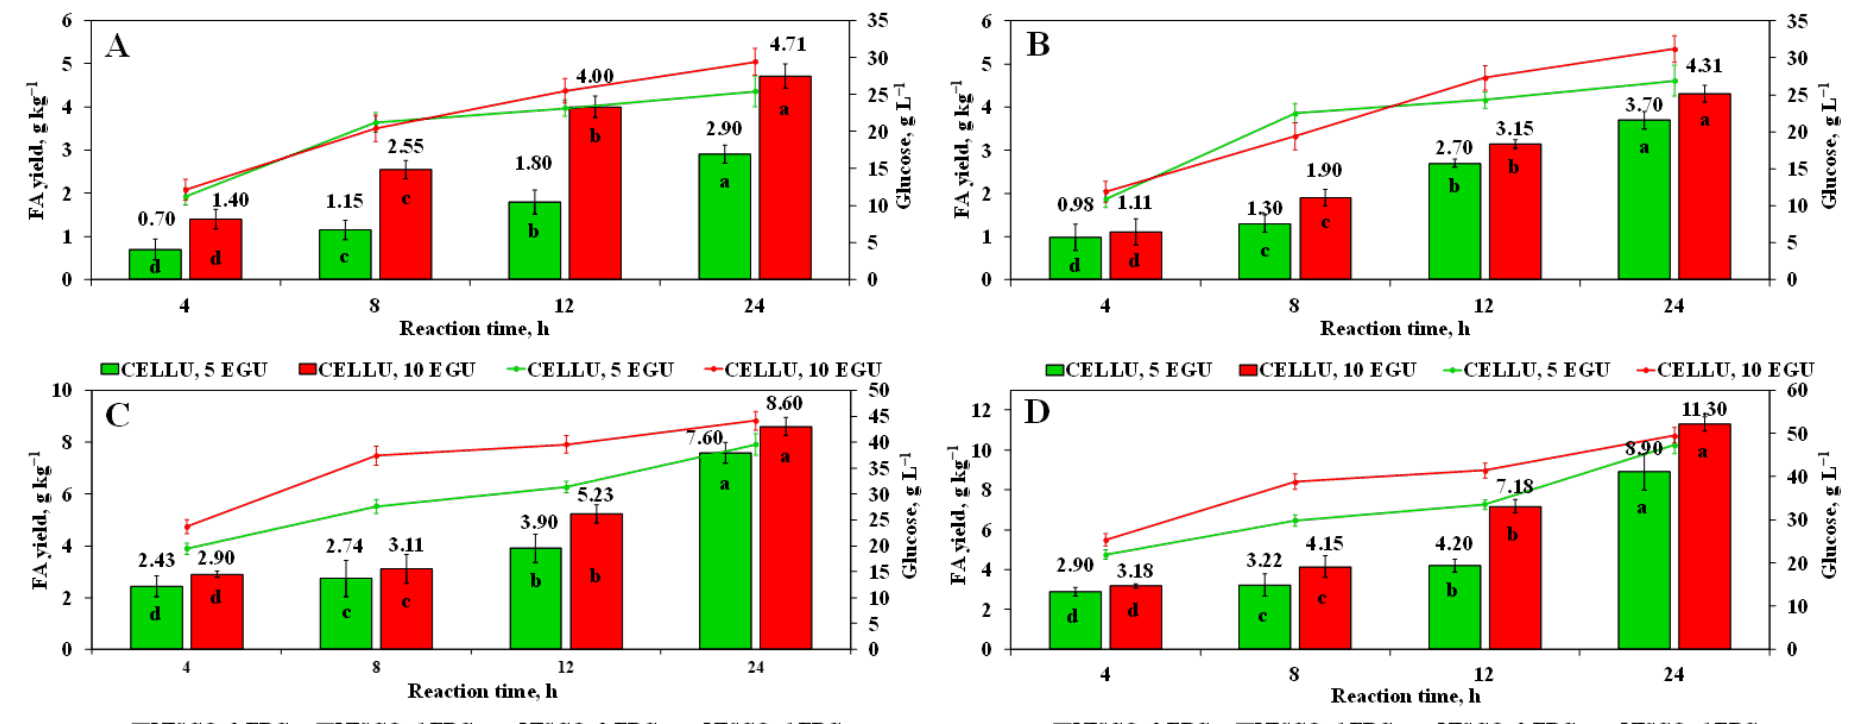
Figure 3. The recovery of FA using enzymatic hydrolysis of wheat ( A , C ) and rye ( B , D ) bran using either Celluclast ® 1.5 L and Viscozyme ® L as a sole hydrolytic enzyme. Note: Values are means ± SD values of triplicates ( n = 3). Means within the same type and dose of enzyme with different superscript letters (a, b, c, and d) are significantly different at p < 0.05. DW–dry weight. Red and green lines on the plots indicate the release of glucose in g L −1 of hydrolysates over 24 h enzymatic hydrolysis either with Celluclast ® 1.5 L and Viscozyme ® L as a sole hydrolytic enzyme.